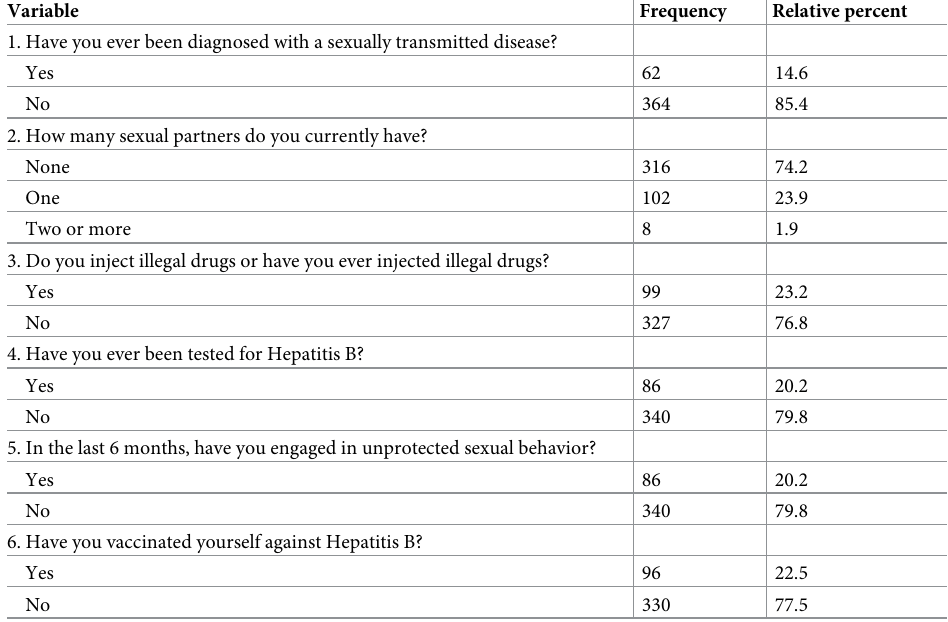
Table 3. Risk factors for hepatitis B